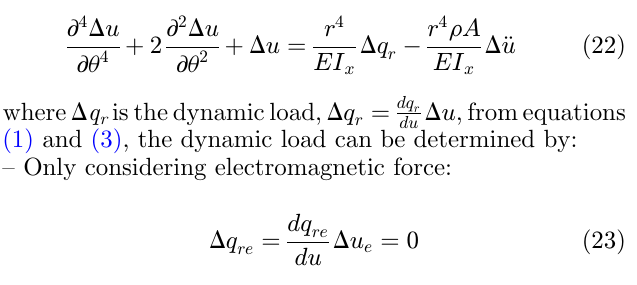
ffiffiffiffiffiffiffiffiffiffiffiffiffi p (cid:1) 1 þ 1 (cid:1) Q